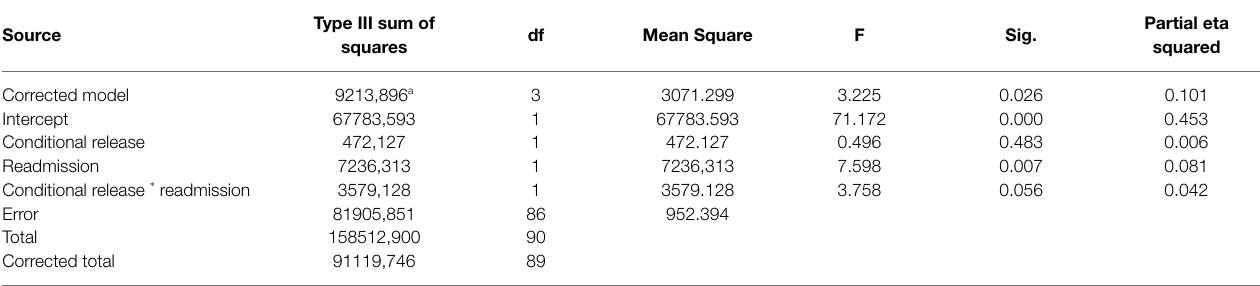
TABLE 3 | Tests of between-subjects effects – dependent variable: length of stay (months). Source